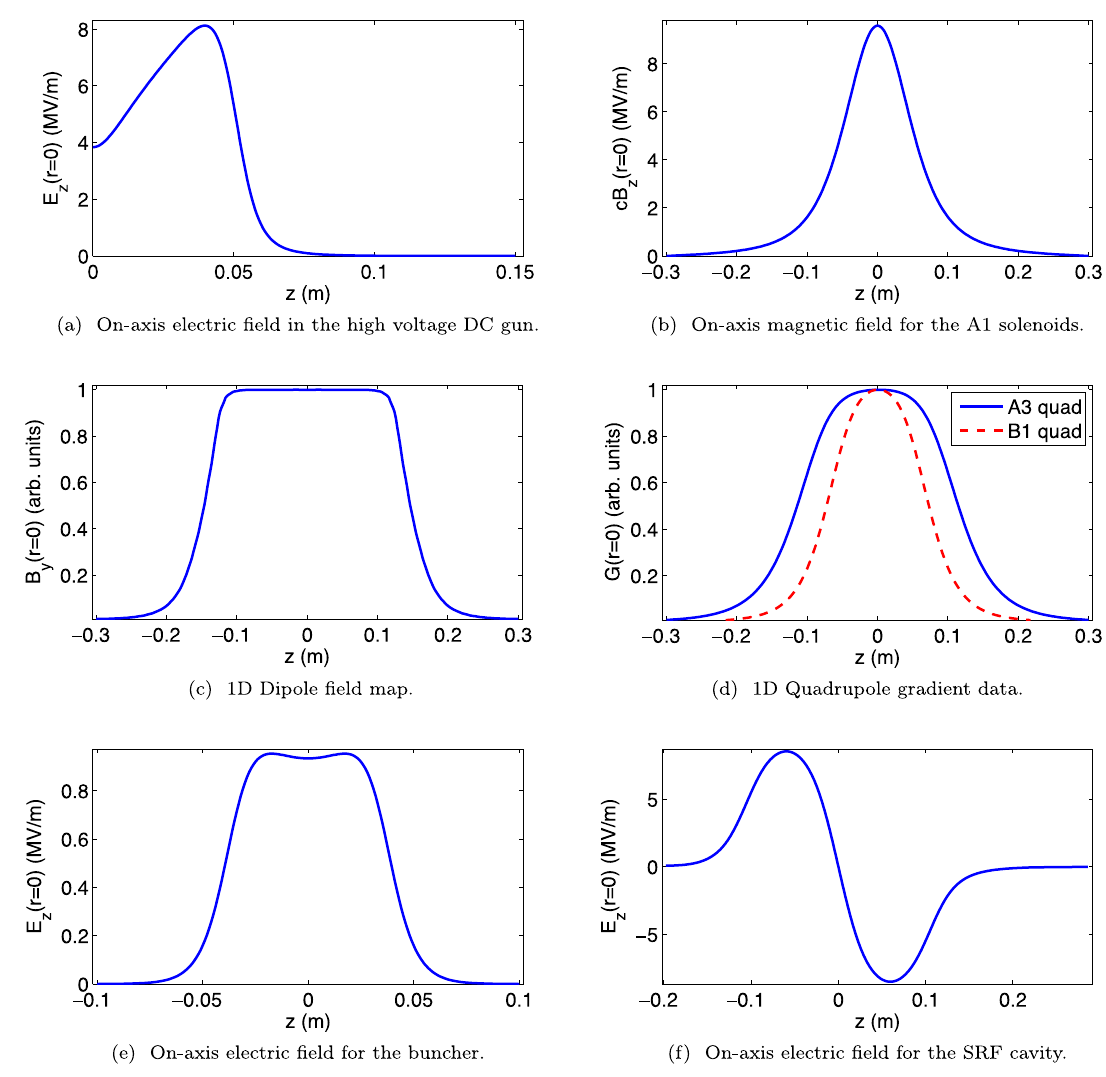
FIG. 3. On-axis electric and magnetic fields for (a) the high-voltage DC gun at 350 kV, (b) emittance compensation solenoid at 3.75 A, (c) the A3 and B1 merger dipoles, (d) the A3 and B1 merger quads, (e) the buncher cavity at 60 kV, and (f) the SRF cavity at 1